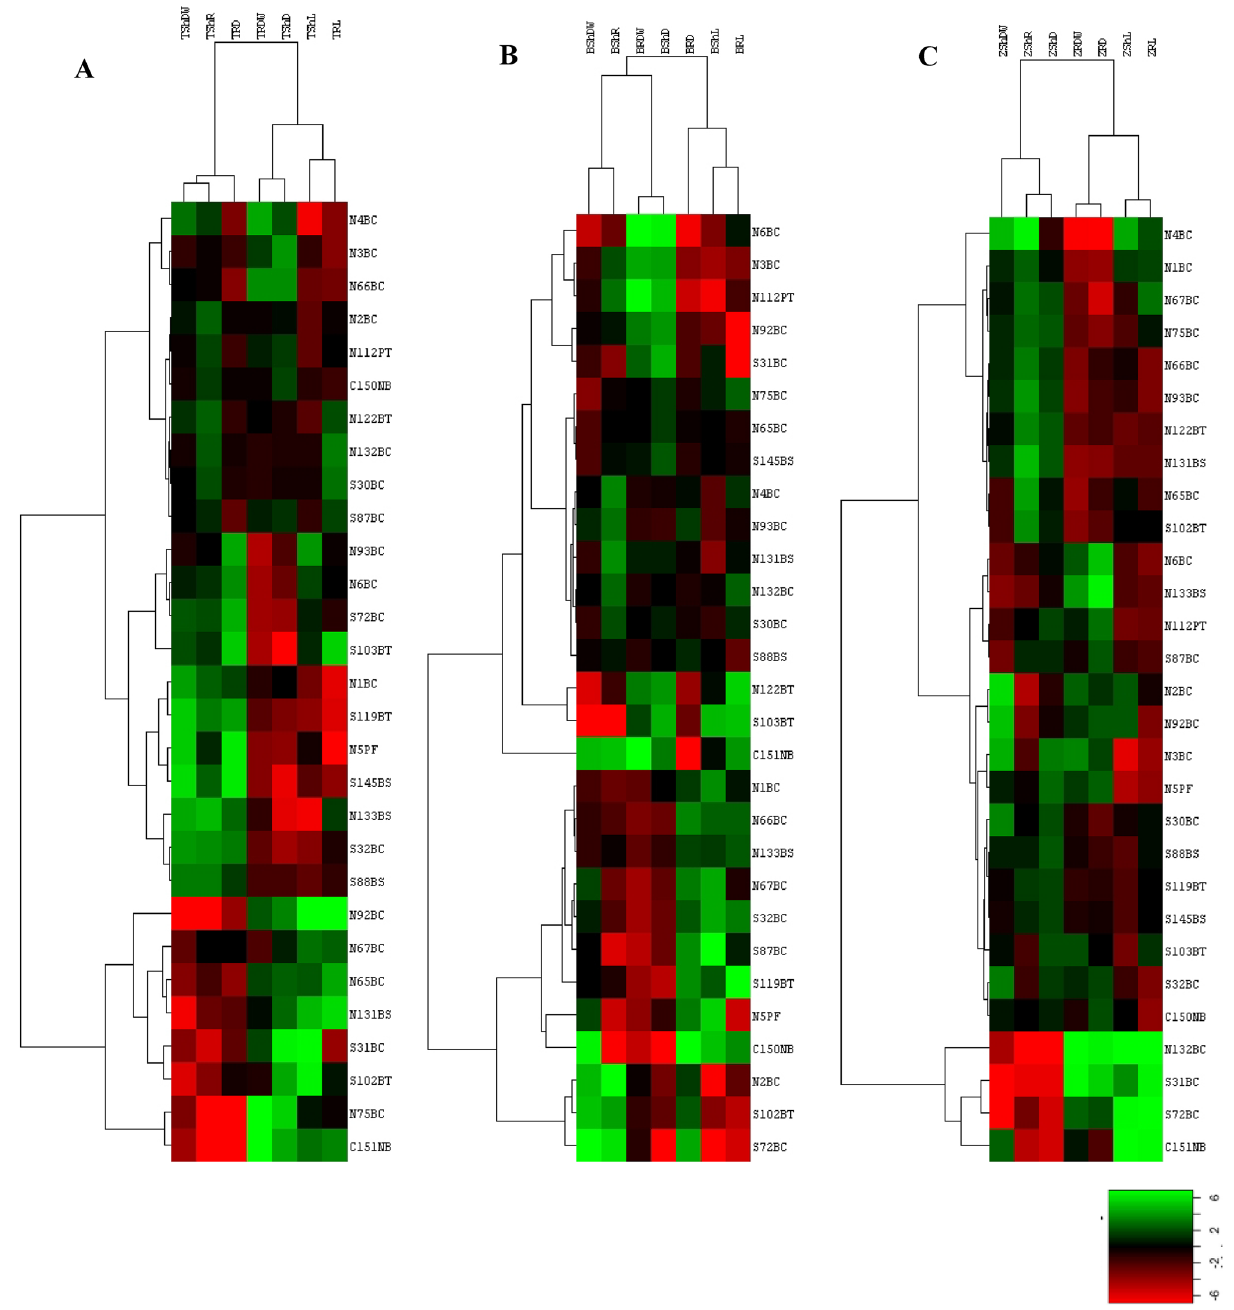
Figure 2. ( A–C ) Represented hierarchical cluster analysis of the effect of isolates on wheat, canola, and maize plants, respectively. Drown by CLUSTER and Treeview softwares. Hierarchical clustering was done based on Euclidian distance and the complete linkage method. Colors were indicated the type of isolates impacts on plants. Accordingly, red, green, and black colors showed positive, negative, and no-effect isolates, respectively. The horizontal axis indicates plant growth parameters: shoot density (ShD), root density (RD), root dry weight (RDW), root length (RL), shoot dry weight (ShDW), shoot length (ShL) and shoot/root weight (ShR). The vertical axis shows the assayed bacterial